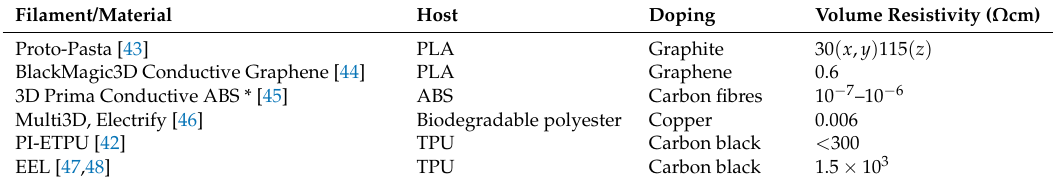
Table 1. Overview of commercially available conductive